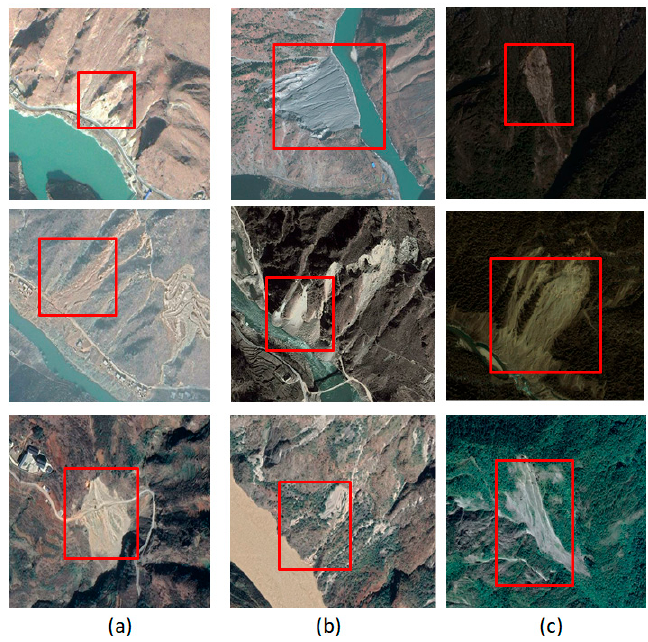
Figure 5. Landslide remote sensing images. ( a ) Image of landslides near highways. ( b ) Images of landslides near rivers. ( c ) Images of landslides of different shapes. The red squares are the landslide areas.